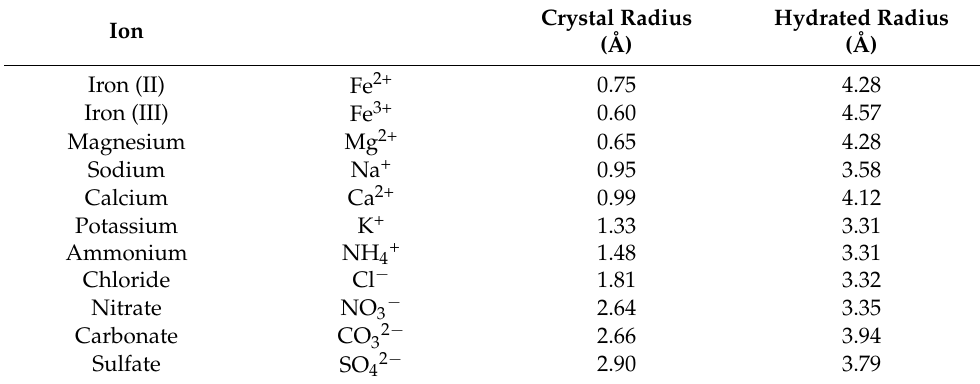
Table 5. Measures of ion size. Copyright 2014. Adapted from [146] with permission from Elsevier Ltd.